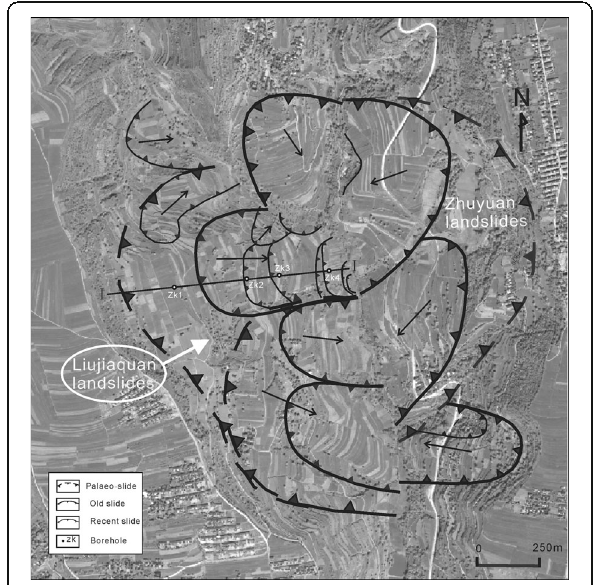
Fig. 3 View of the Zhuyuan and Lijiaquan landslides from a Quickbird